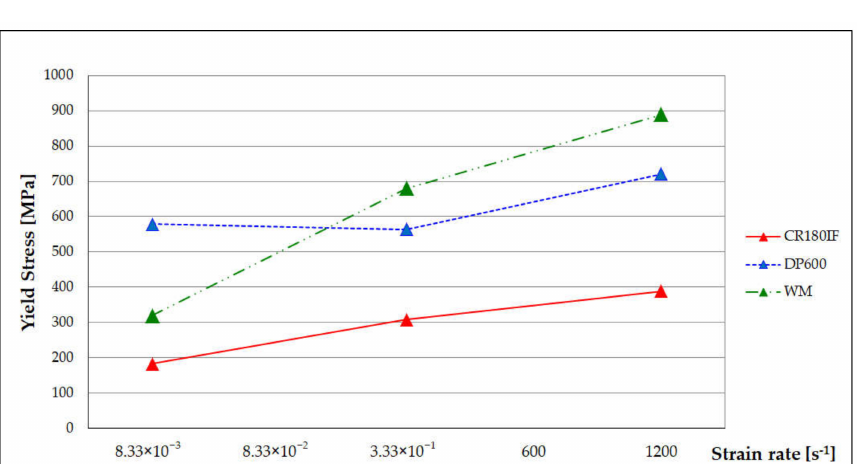
Figure 8. Dependence of the yield strength (YS) on the tested steels’ strain rate and welded